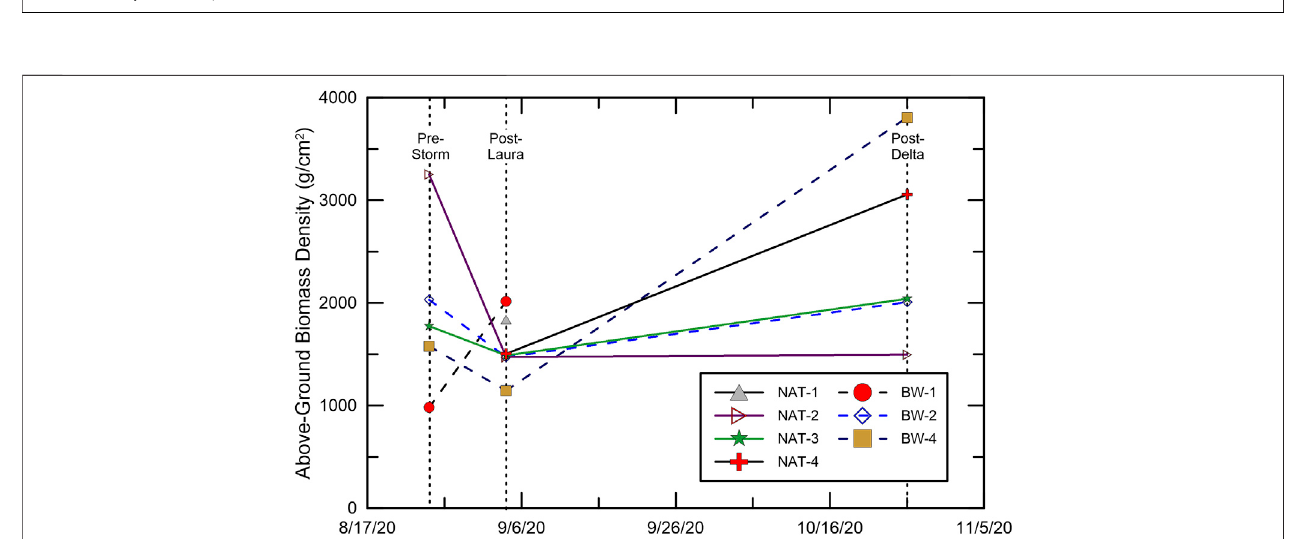
FIGURE 11 | Water depth with time at BW-2 and BW-4, and NAT-2 and NAT-4.